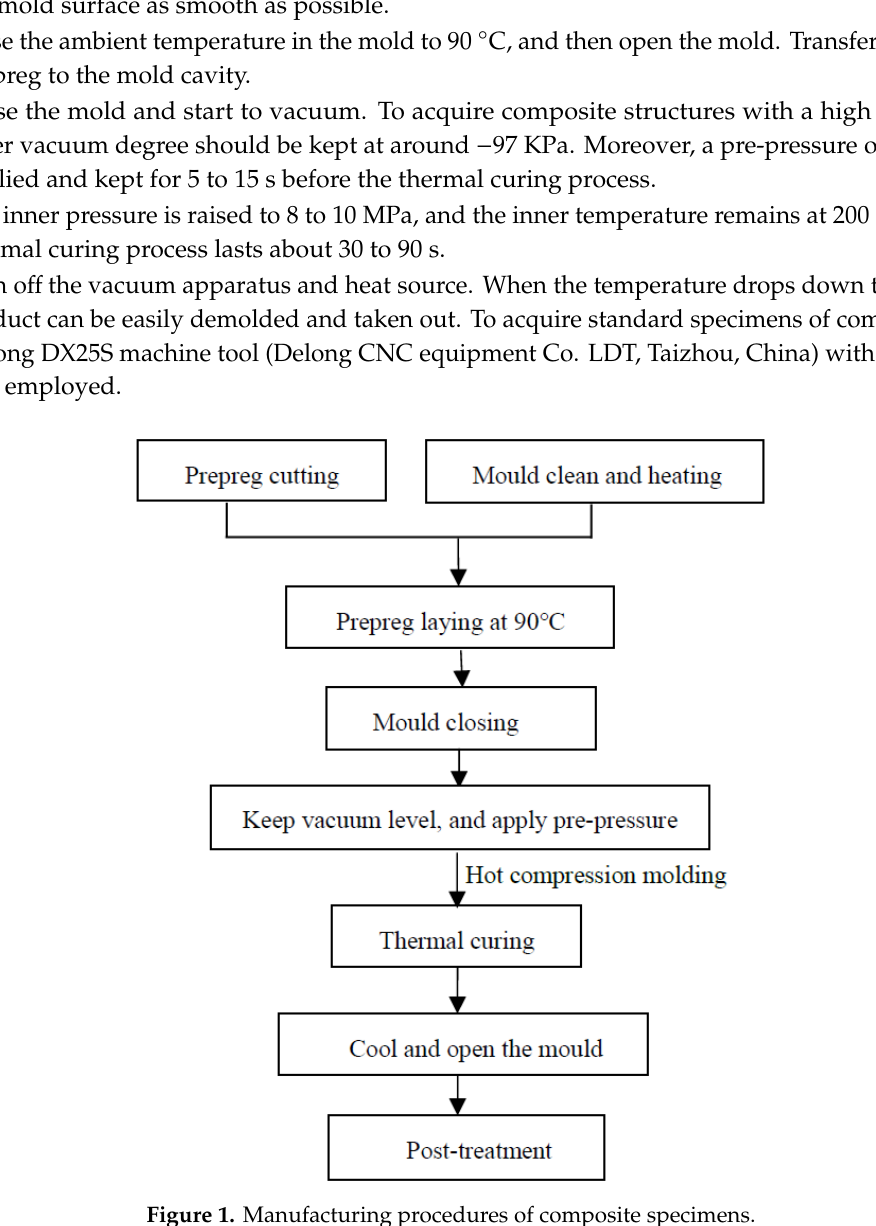
Figure 1. Manufacturing procedures of composite specimens.